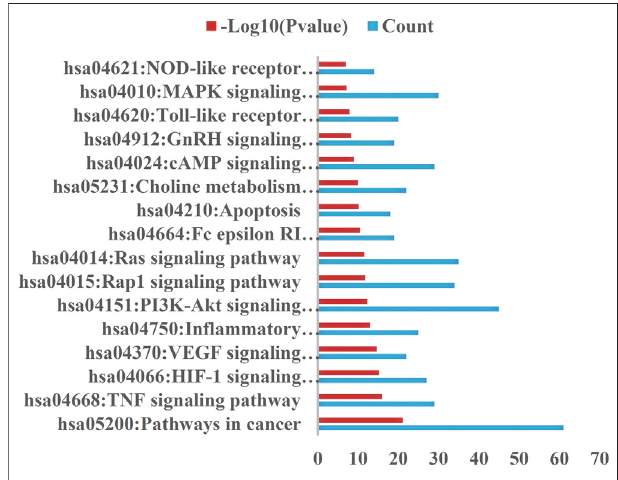
FIGURE 7 | KEGG pathway. Setting the screening conditions of p < 0.01andFDR < 0.05,117KEGGpathwayswereobtainedfrom291target genes with intersection in DAVID database, and only 16 major pathways are shown in this fi